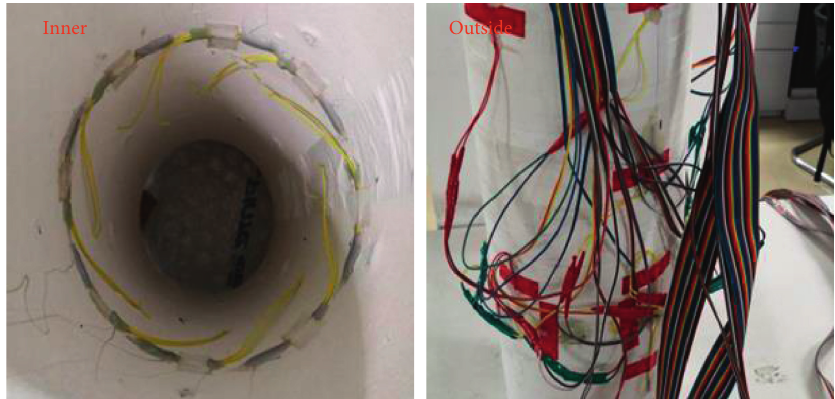
Figure 6: Tunnel lining monitoring